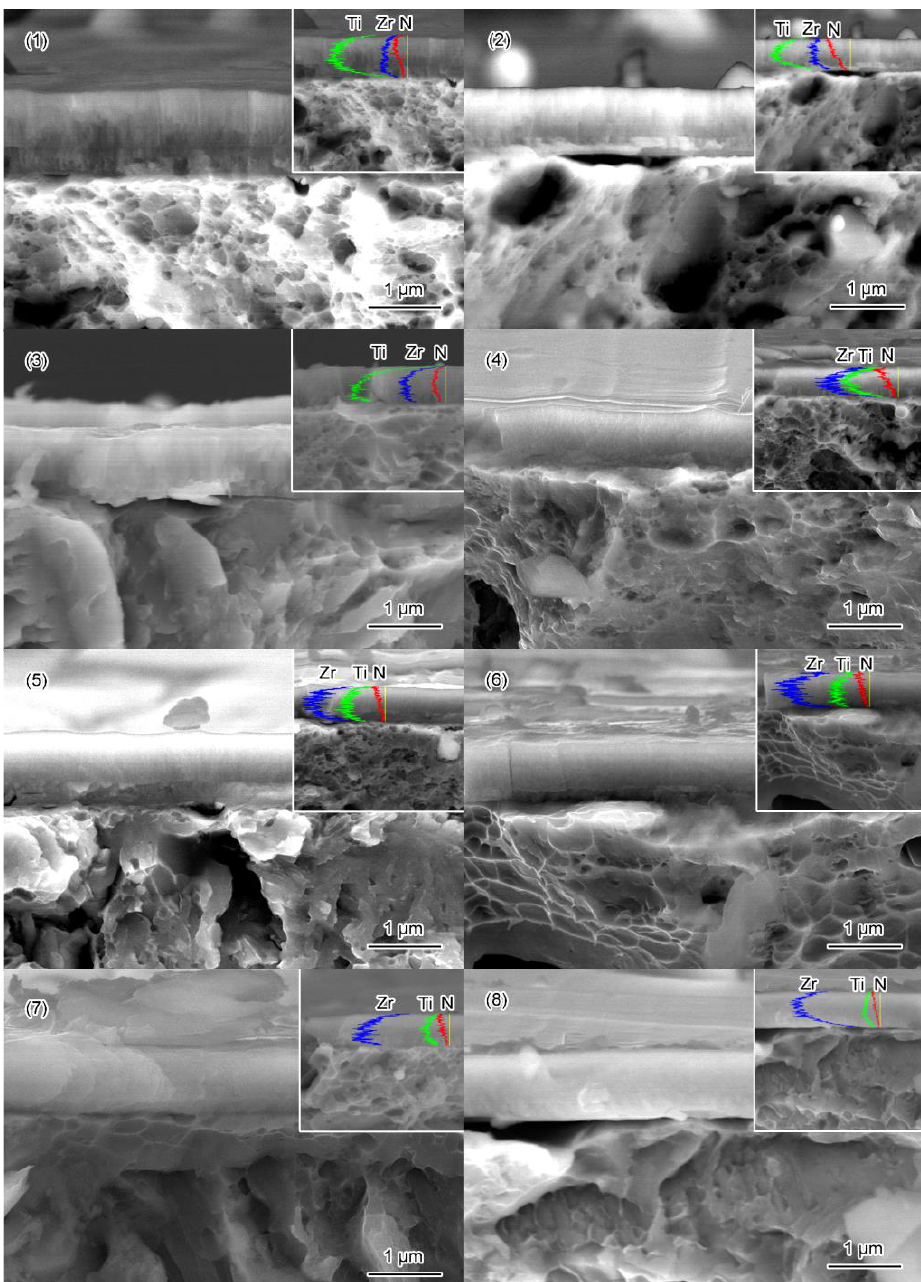
Figure 3. Cross-sectional morphology and elemental distribution in the growth direction of the films. The numbers (1) – (8) correspond to sample numbers 1 – 8, respectively.